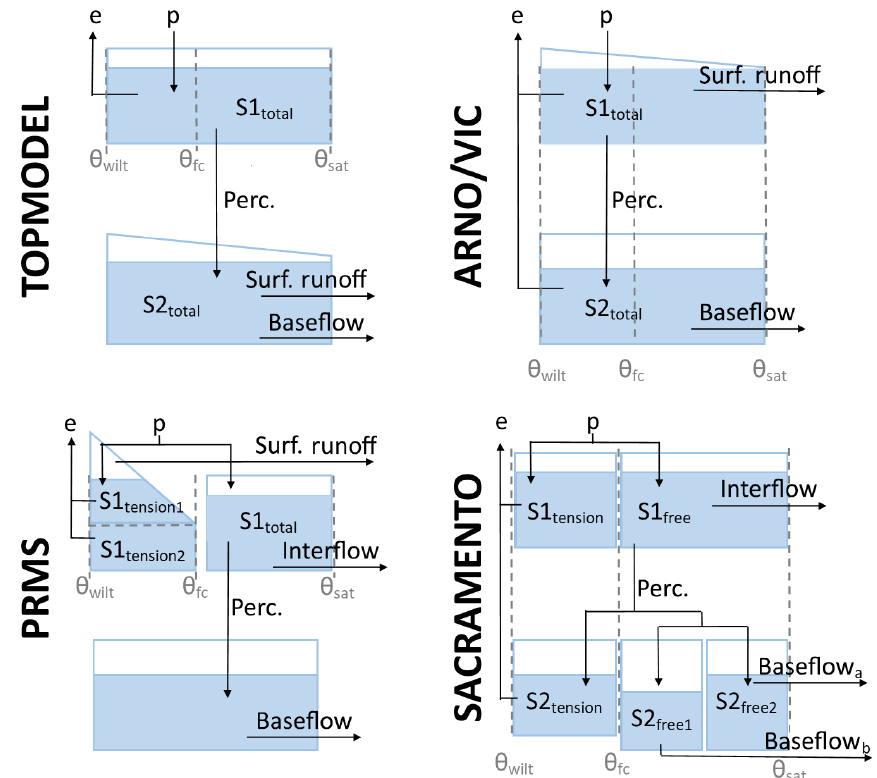
Figure 3. FUSE wiring diagram, showing the model structure decisions. TOPMODEL and ARNO/VIC have 10 parameters, PRMS has 11 parameters, and SACRAMENTO has 12 parameters. Adapted from Clark et al.